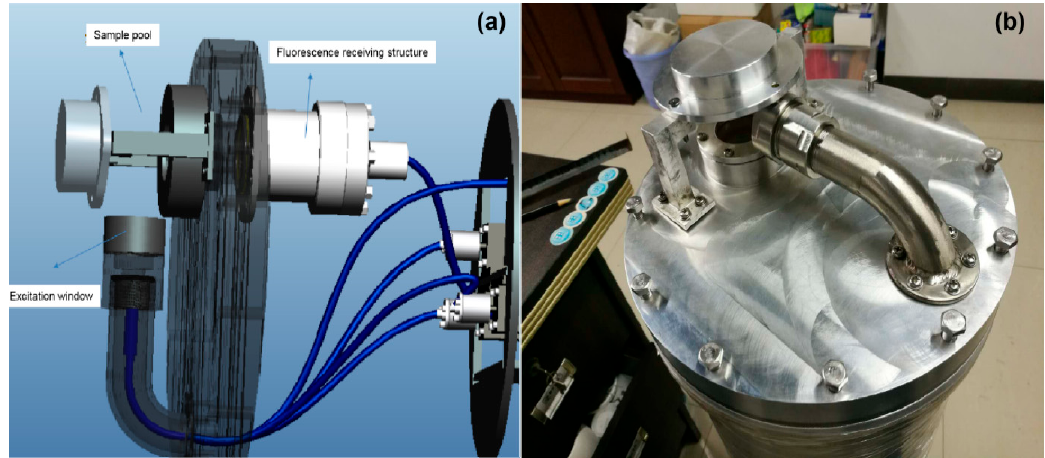
Figure 1. Schematic of a laser-induced fluorescence (LIF) system.